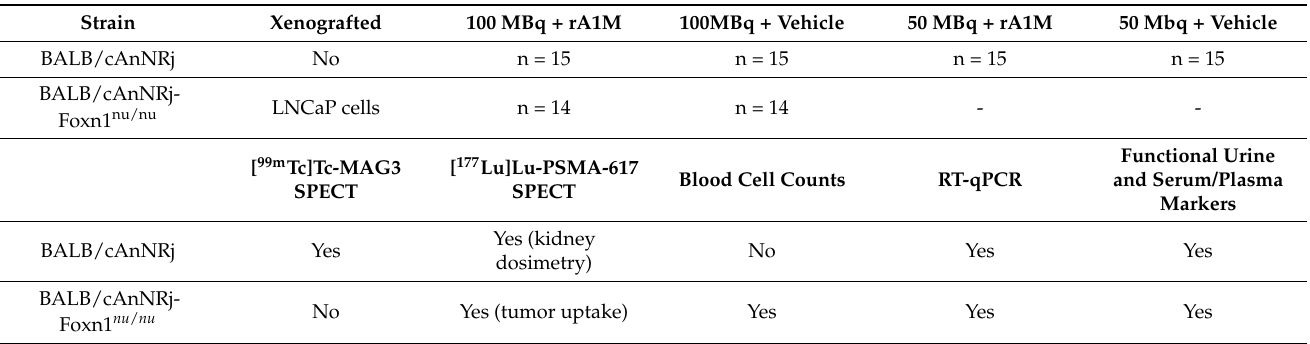
Table 1. Preclinical study